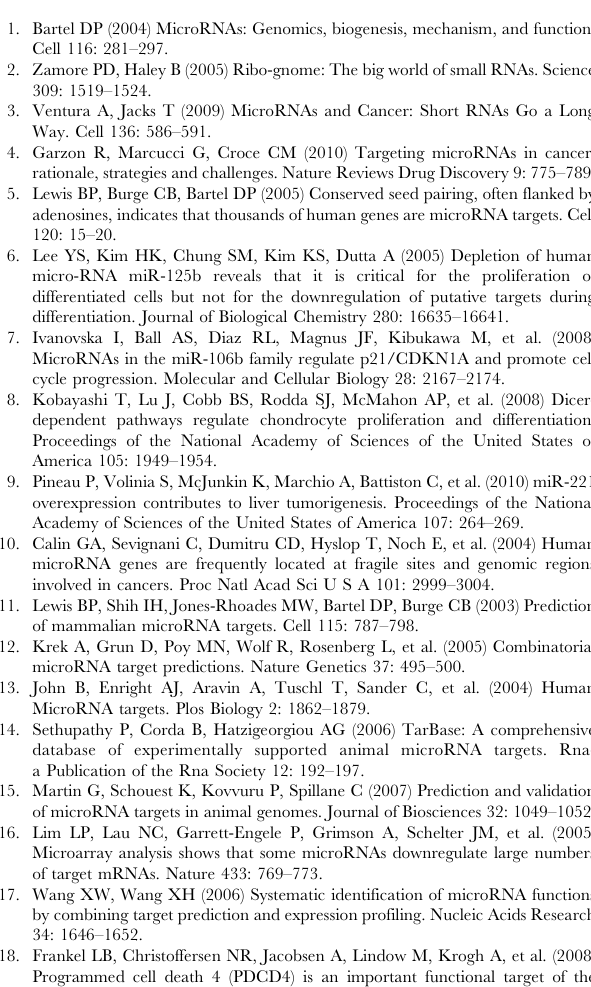
Figure S4 Construction of the luciferase vectors. The miR-17–92 target sites of the candidate genes were cloned downstream of the luciferase ORF at the Xba I restriction site of the pTK-hRG vector. The miRNA target sites are shown as nucleotide sequences (left) and as boxes (right). Sense (upper) and antisense (lower) strands of complementary sequences indicate the miRNA target site of mRNA 3 9 UTR and the corresponding miRNA sequences, respectively. Seven nucleotides (red) on miRNAs show the seed sequences for binding with mRNA. Table S1 Candidate targets of the miR-17–92 cluster identified by